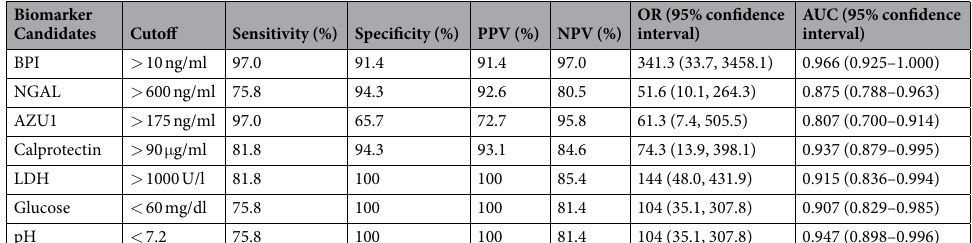
Table 5. Diagnostic accuracy of individual pleural fluid tests for distinguishing CPPE as compared with UPPE. PPV: positive predictive values; NPV: negative predictive values; AUC: area under ROC curve; BPI: bactericidal permeability-increasing protein; NGAL: neutrophil gelatinase-associated lipocalin; AZU1: azurocidin. The parapneumonic effusion (PPE, refer to UPPE and CPPE) and non-parapneumonic effusion (non-PPE, refer to transudates, other exudates, and malignant) in this study.